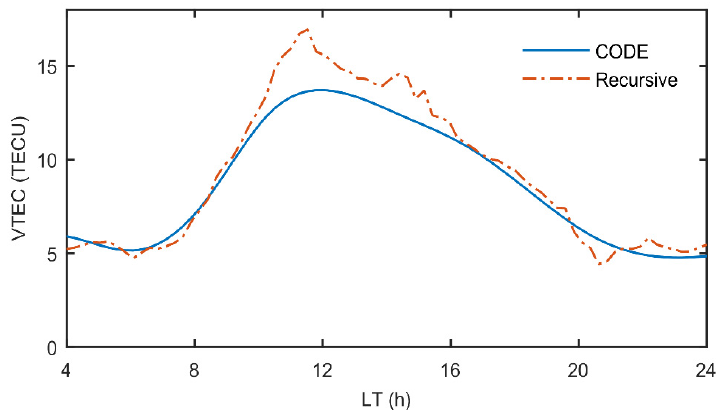
Figure 2. A comparison between the vertical total electron content (VTEC) derived from the recursive local model (orange line, denoted by recursive) and the global ionospheric model (GIM) from the Center for Orbit Determination in Europe (CODE) (blue line, denoted by CODE) over GODZ station on 15th January 2011.